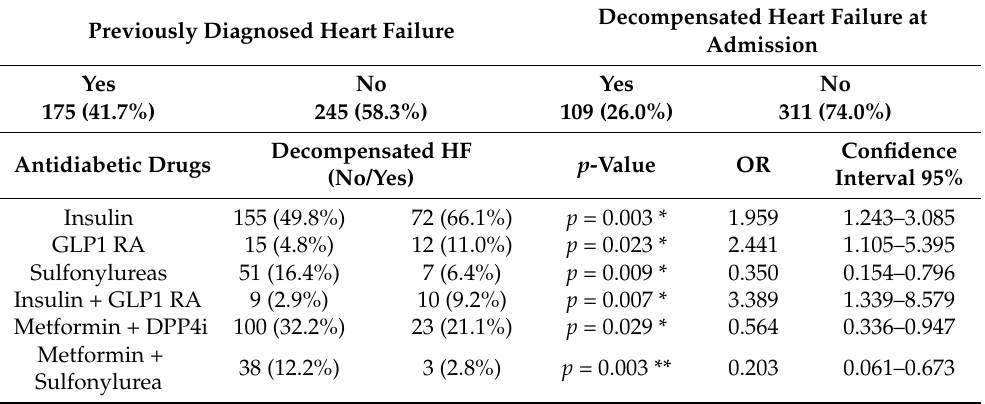
Table 3. Relationship between decompensated heart failure and antidiabetic therapy. Previously Diagnosed Heart Failure